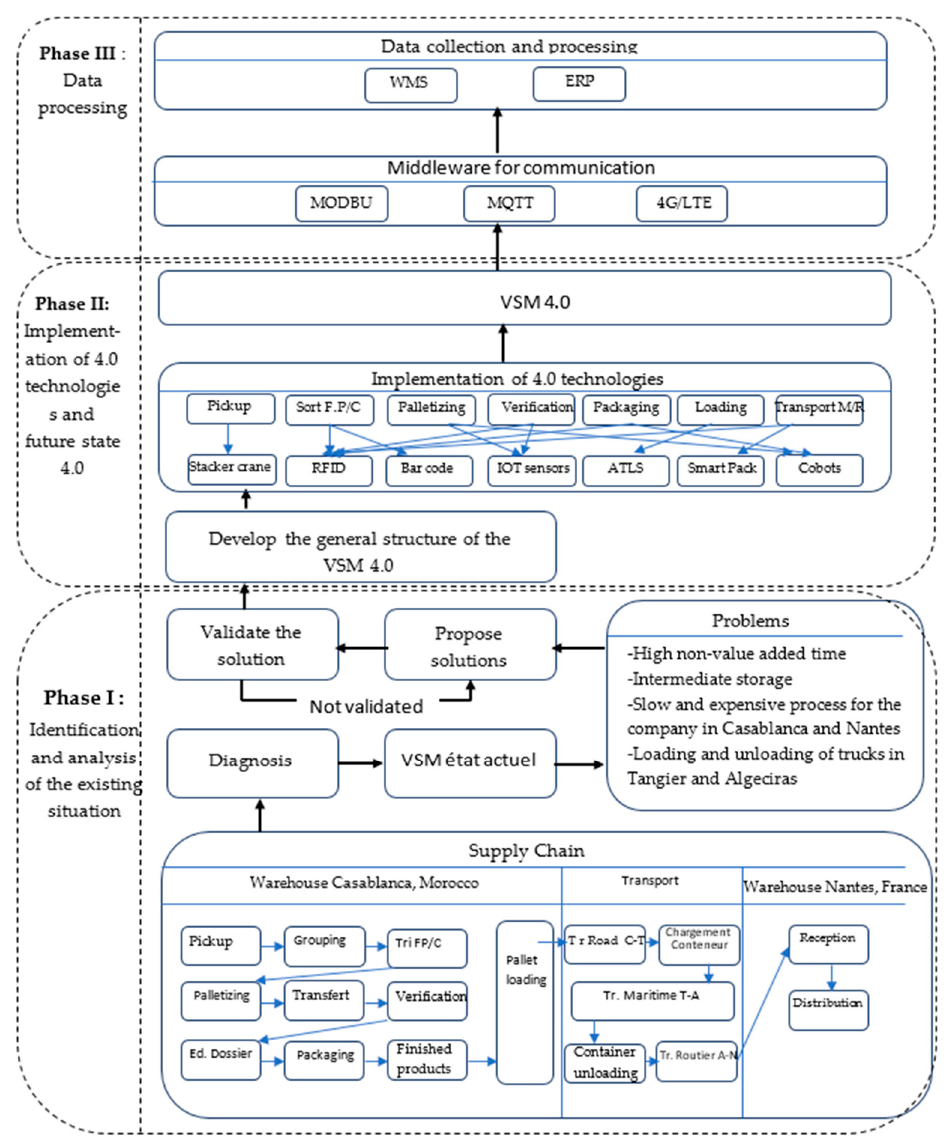
Figure 6. VSM 4.0 implementation methodology.